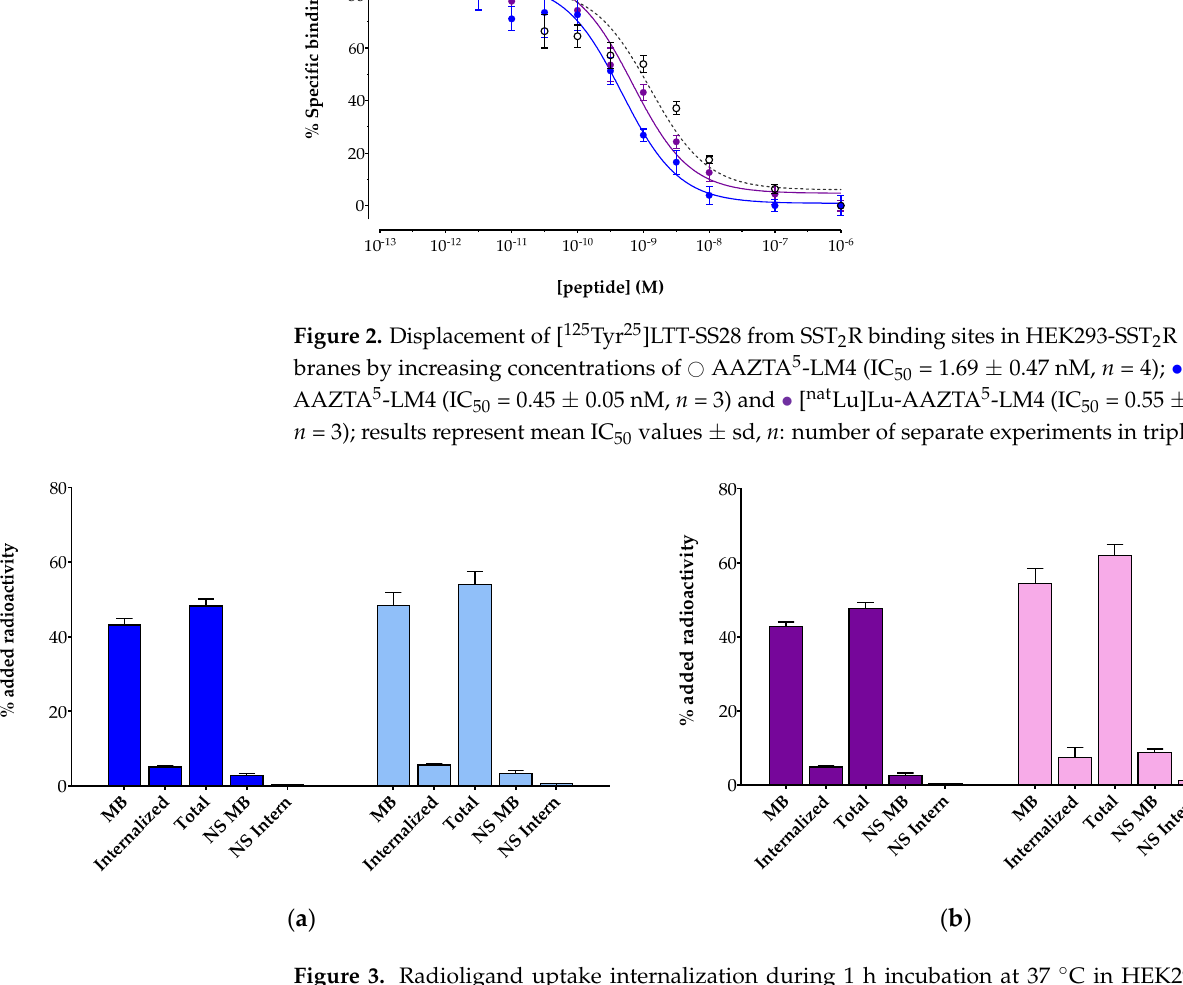
Figure 3. Radioligand uptake internalization during 1 h incubation at 37 °C in HEK293 ‐ SST 2 R cells. ( a ) , [ 111 In]In ‐ AAZTA 5 ‐ LM4 and , [ 111 In]In ‐ DOTA ‐ LM3; ( b ) , [ 177 Lu]Lu ‐ AAZTA 5 ‐ LM4 and , [ 177 Lu]Lu ‐ DOTA ‐ LM3; MB = specific membrane bound, Internalized = specific internalized; Total = specific MB + specific Internalized, NS MB = non ‐ specific MB, NS Intern = non ‐ specific internalized. Results were acquired from 3 independent experiments performed in triplicate.